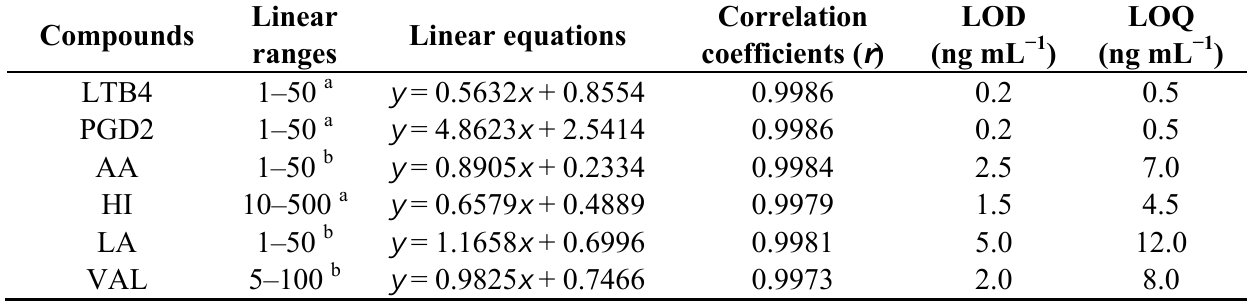
Table 1. Standard curves, correlation coefficients ( r ) and linear ranges, LOD and LOQ of the six compounds in serum from rats (n =